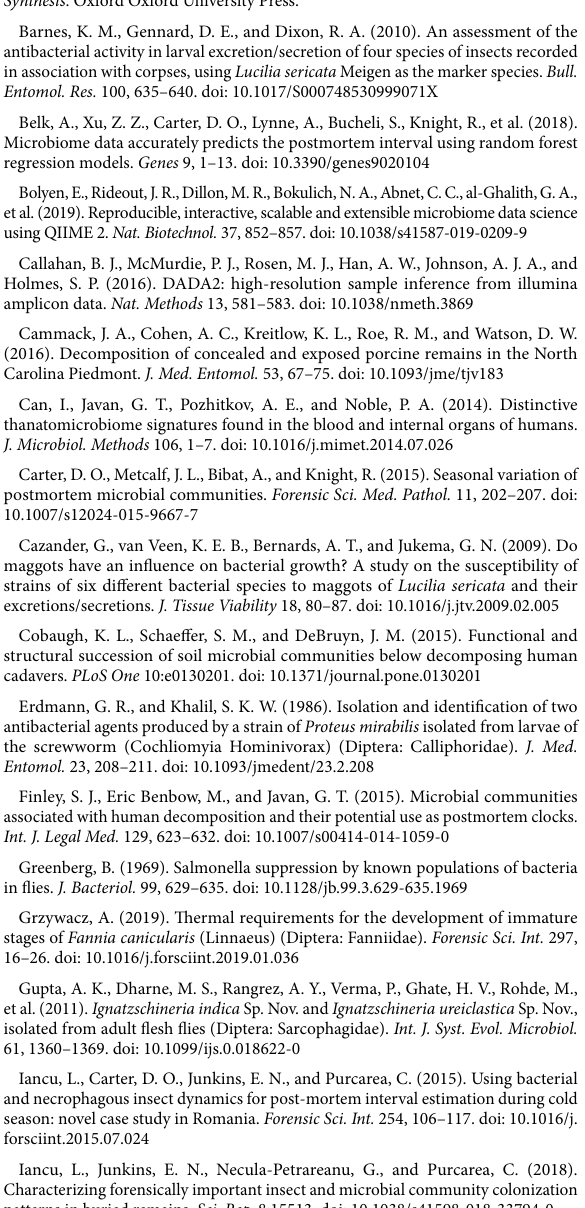
Actinobacteria, Bacteroidetes, Firmicutes, and Gammaproteobacteria were measured at different times of decomposition using sequencing and qPCR. Results were compared for concordance and ability to determine post-mortem interval in summer and winter samples. Using qPCR, PMI is best identified using presence of Firmicutes and Bacteroidetes as detectors of early timepoints, and Gammaproteobacteria and Actinobacteria and indicators of later timepoints. Results between sequencing and qPCR varied in the winter samples due to the qPCR’s inability to detect early presence of